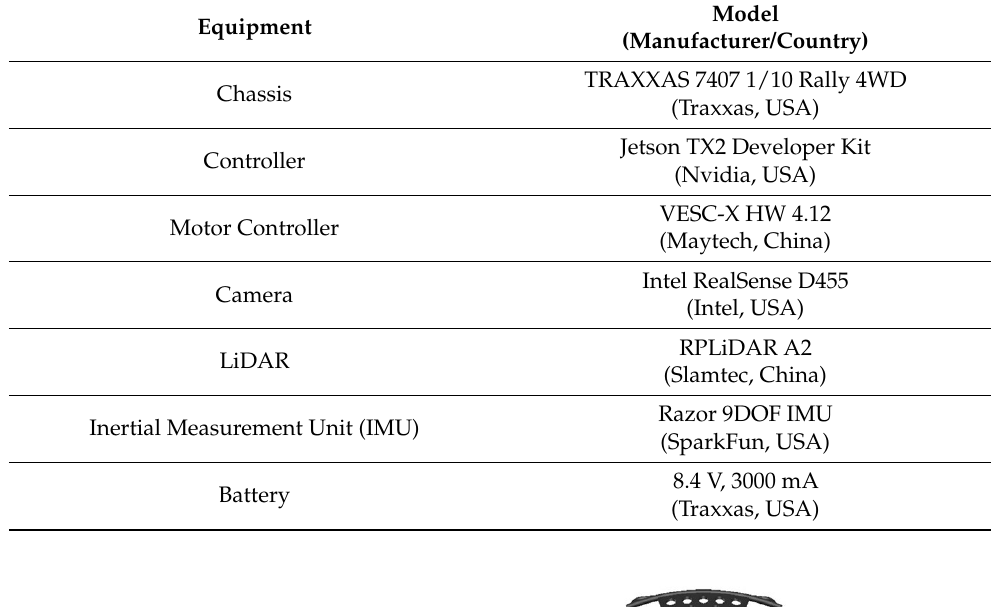
Table 1. Hardware list of the autonomous mobile robot.